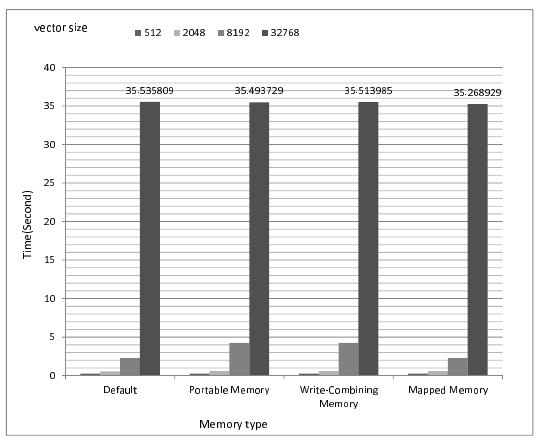
The overheads in restart phase is shown in